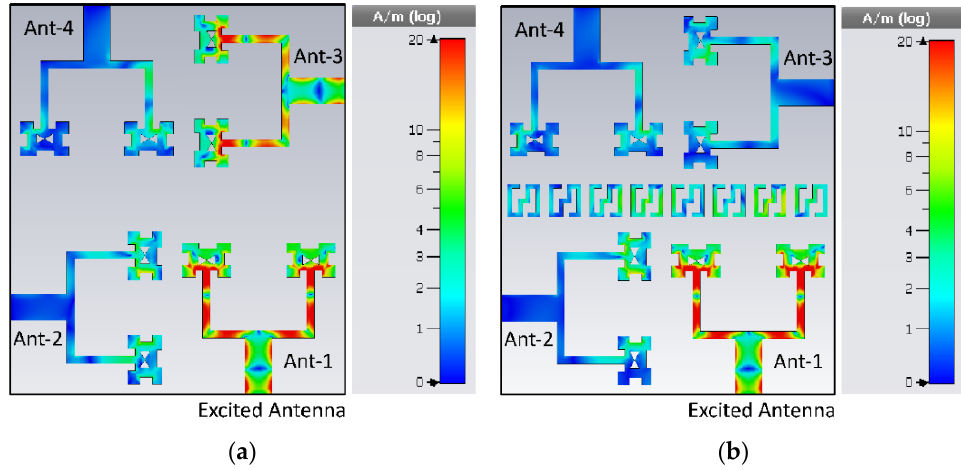
Figure 7. Surface current distribution at 28 GHz: ( a ) without decoupler; ( b ) with decoupler.